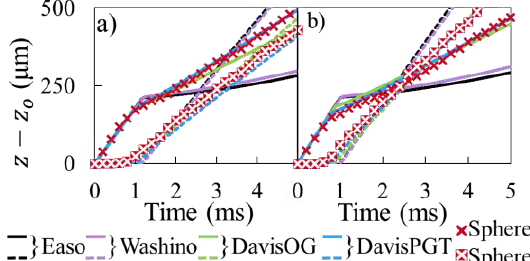
Fig. 3. Change in position during a collision for 2 SS spheres with 3000 cP oil coating with Stokes ’ numbers of a) 2.7 and b) 3.1, corresponding to an agglomeration collision and a separation collision, respectively. The symbols represent the experimental data. The solid lines represent the striker sphere (1) and the dashed lines represent the initially still sphere (2).